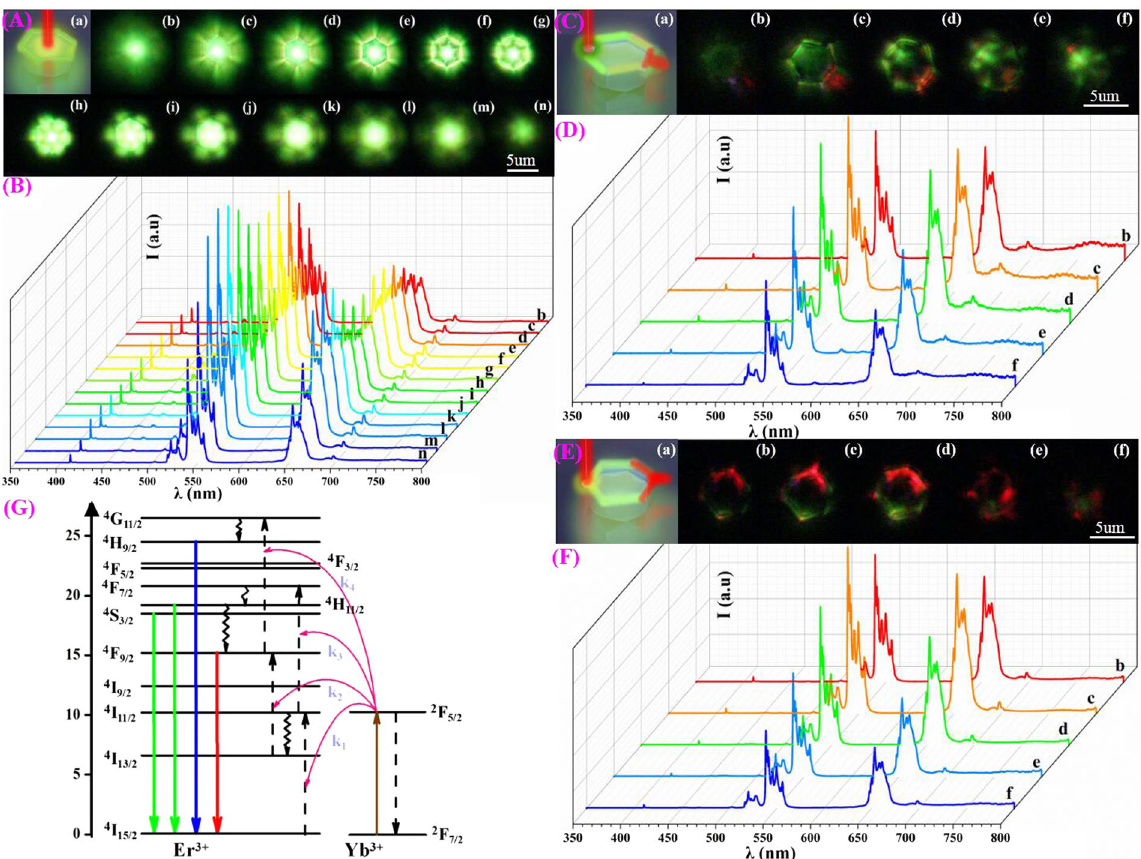
Figure 3. UC emission spectra and luminescence pattern photographs from single PS β HM on a quartz substrate. ( A ) and ( B ), ( C ) and ( D ), ( E ) and ( F ) are luminescence emission patterns and spectra when the particle is excited at the center, side edge, and corner of the microcrystal particle, respectively. (b) to (n) in the Figures ( A ) and ( B ), (b) to (f) in the Figures ( C ) and ( D ), ( E ) and ( F ) correspond to different vertical position of the excitation focal point (During the experimental measurement, the depth of the excitation focal